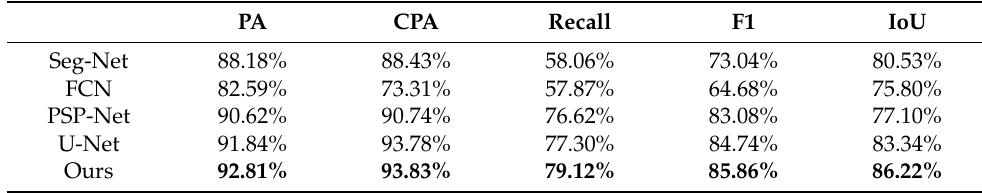
Table 5. Small cloud detection